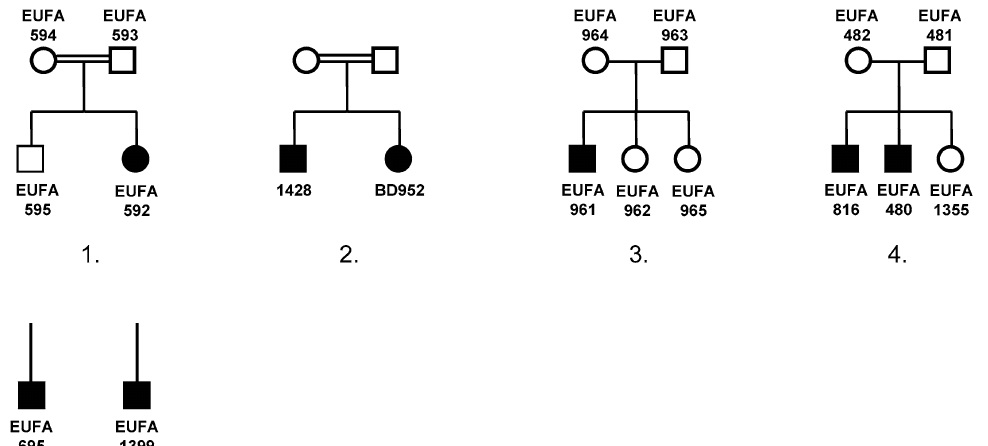
Fig. 1. FA-I families and patients analyzed in this study. Filled-in symbols are the affected individuals. Families 1–4 were used to delineate the candidate regions for FANCI by homozygosity mapping (patients EUFA592, BD952, and 1428 in consanguineous families 1 and 2) and linkage analysis (families 3 and 4). DNA samples from both parents of individuals BD952 and EUFA695, and from the father of EUFA1399 were not available.